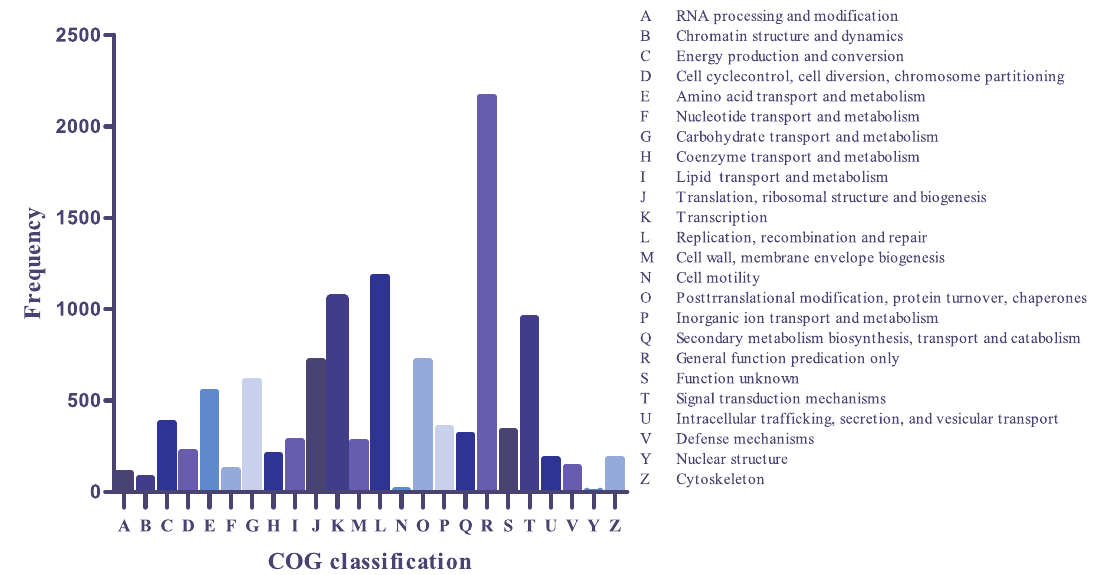
Figure 2. Histogram of COG clusters of the I.indigotica unigenes. Out of the 33,238 de novo assembled unigenes, 7,707 had a match in COG and were grouped into 24 clusters.